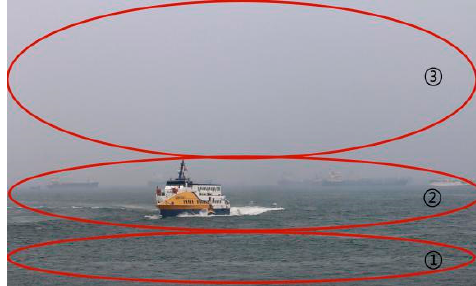
Figure 1. Semantic regions in an image. The bottom ① and top ③ regions represent water and the sky, respectively. The middle ② component can represent land, parked boats, a haze above the horizon or a mixture of these.